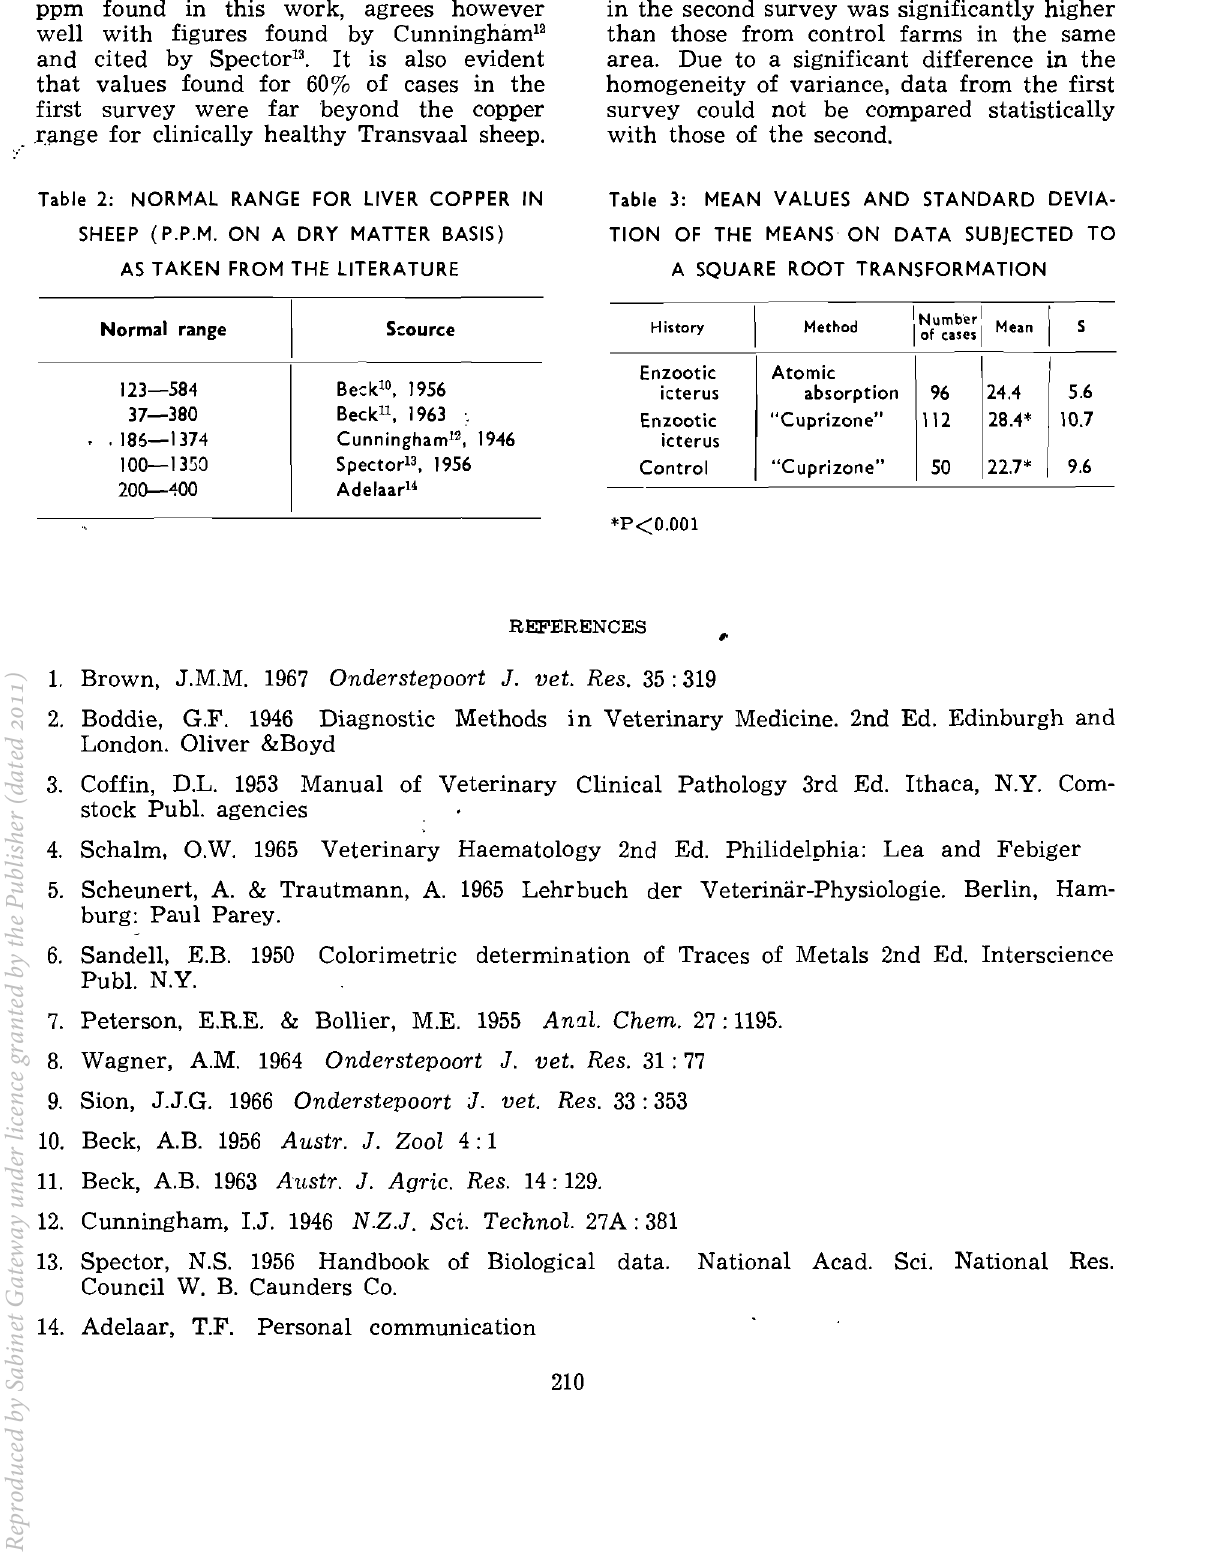
Table 3: MEAN VALUES AND STANDARD DEVIA TION OF THE MEANS ON DATA SUBJECTED